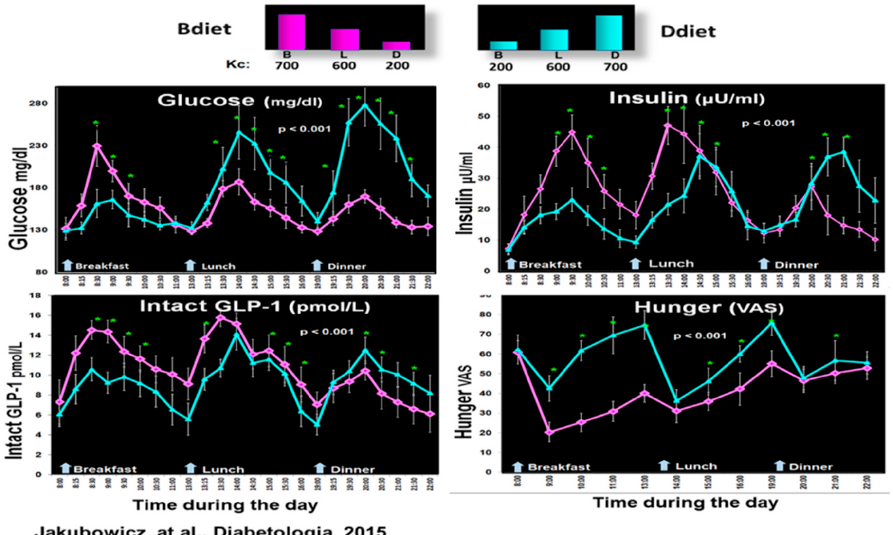
Figure 4 . Effect of early-timed high energy breakfast diet (Bdiet) versus high energy dinner diet (Ddiet) on postprandial glycemia, insulin, intact GLP-1, and hunger scores in T2D. In the upper part is shown the caloric content for Breakfast (B), Lunch (L), and Dinner (D) on Bdiet day (pink) and Ddiet day (blue). The line charts show an all-day graph for overall postprandial glycemia, insulin, intact GLP-1, and hunger VAS in Bdiet vs. Ddiet group. * p < 0.05 “Reproduced and adapted with permission”